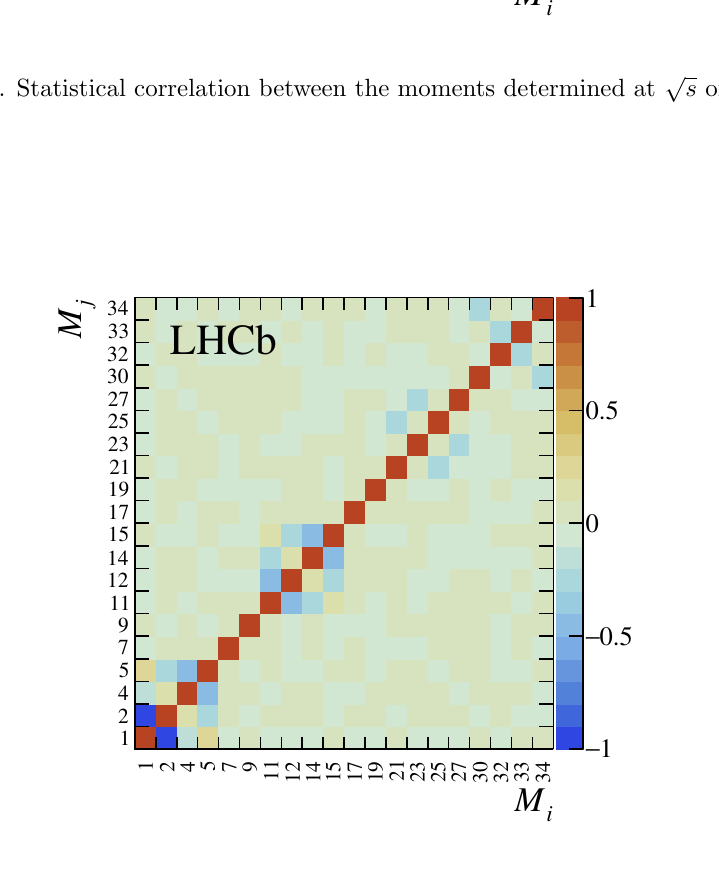
Figure 9 . Statistical correlation between the moments determined at